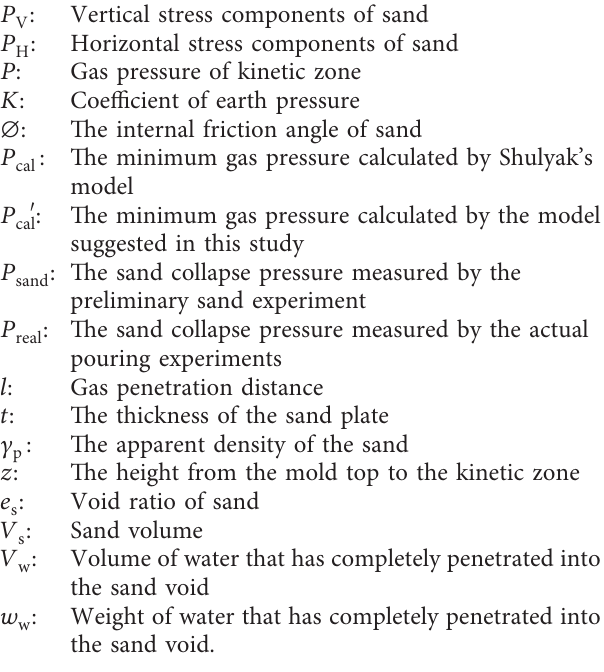
Table 6: Simple regression report.